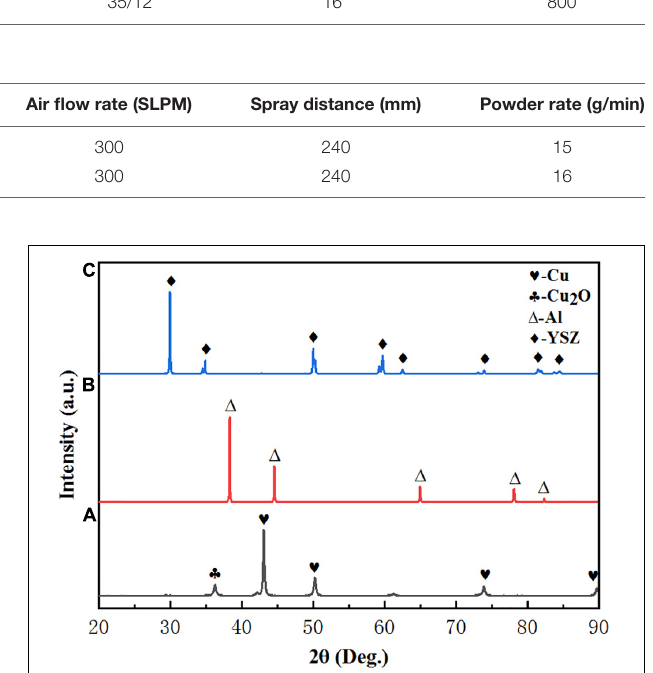
FIGURE 1 | XRD patterns of as-deposited coatings: (A) Cu, (B) Al, and (C)